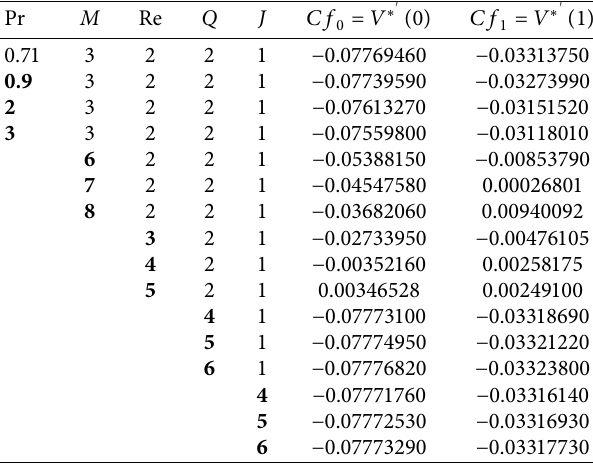
Table 2: Results of skin-friction coefcient for various values of physical parameters.